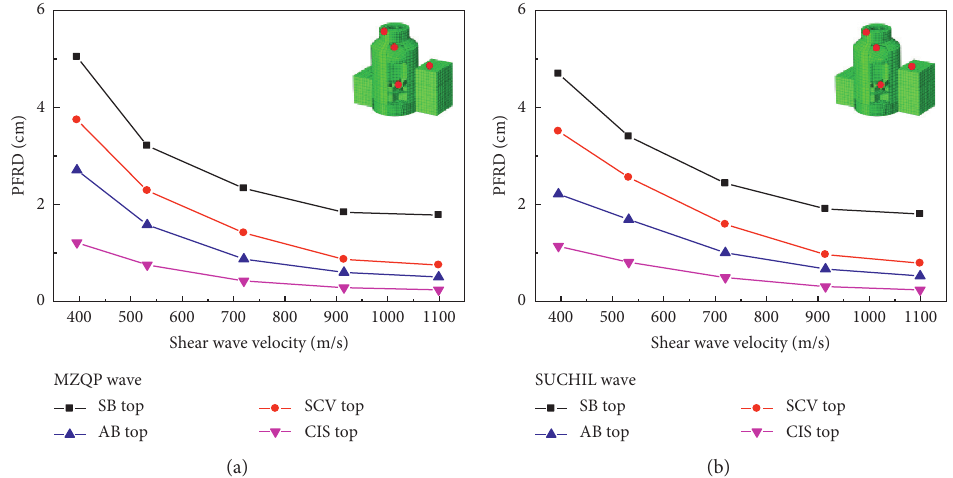
Figure 15: Relationship between the shear wave velocity of the SR site and the PFRD of the nuclear island